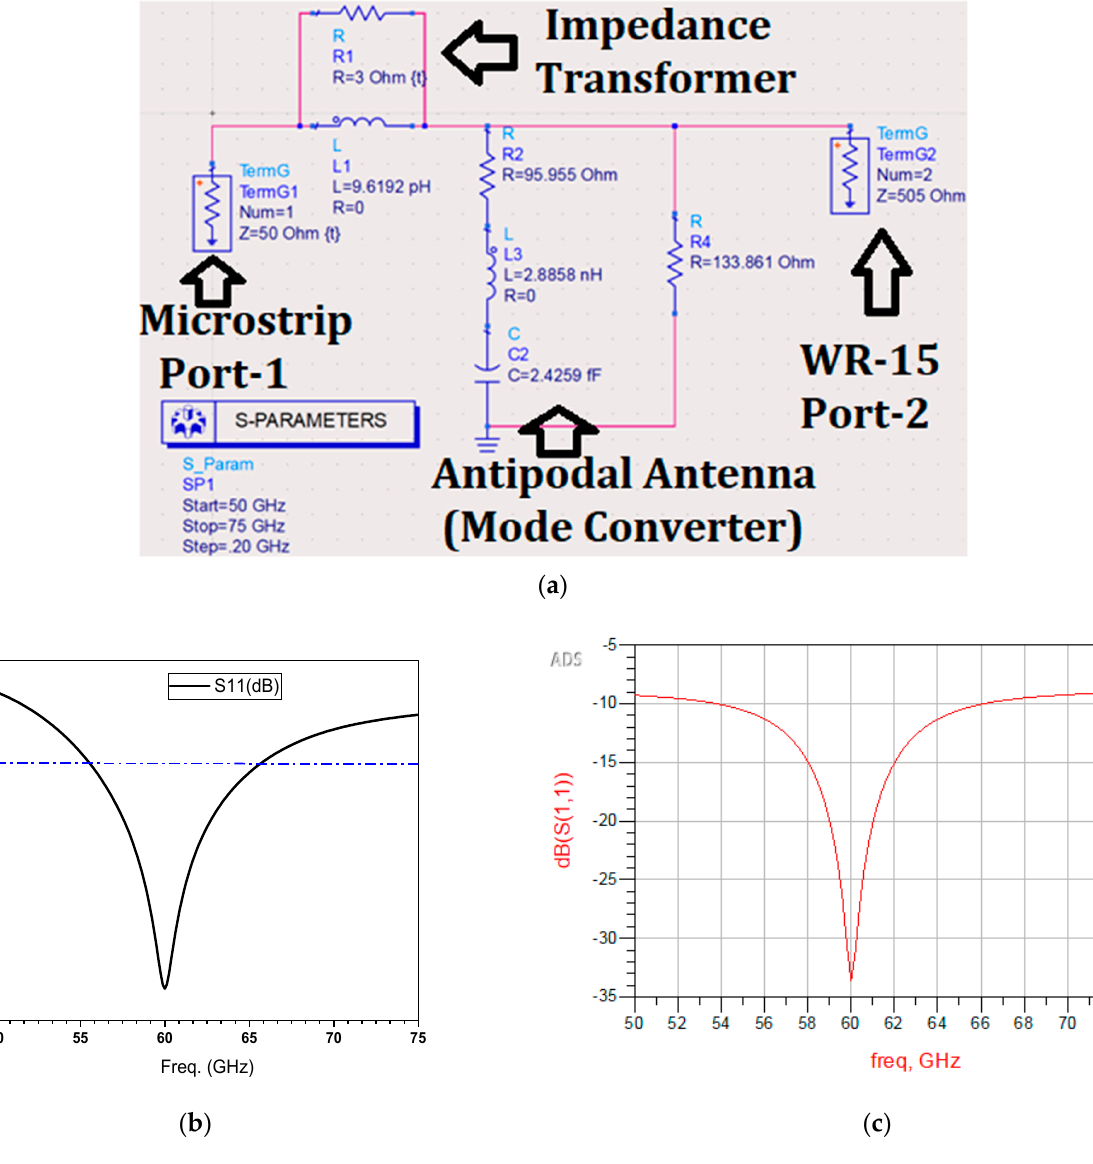
Figure 10. Electrical equivalent circuit of the proposed MS line-to-waveguide transition model: ( a ) electrical equivalent circuit of the model, ( b ) HFSS reflection coefficient plot, and ( c ) validation of electrical equivalent circuit model using ADS RF circuit simulator.